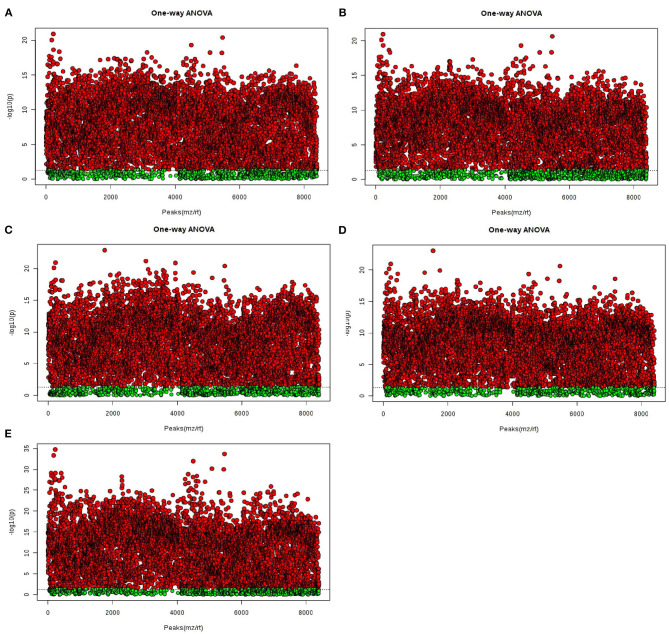
The ANOVA volcano maps of samples. (A) NG0-G8-G12; (B) NG0-G8-NG8; (C) NG0-G12-NG12; (D) NG0-NG8-NG12; (E) G8-G12-NG0-NG8-NG12. The red point represents p < 0.05, which means there is a significant difference.